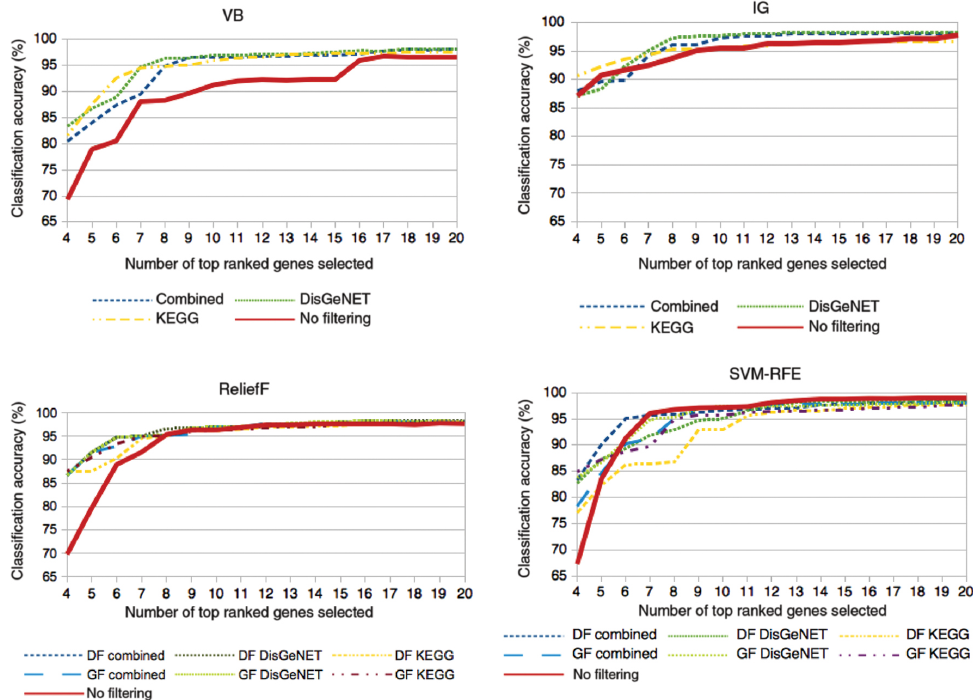
Figure 5: Classification accuracies on dataset I for the respective traditional gene selection approaches and their combina- tion with external knowledge: Variance-based (VB), Information Gain (IG), ReliefF, and